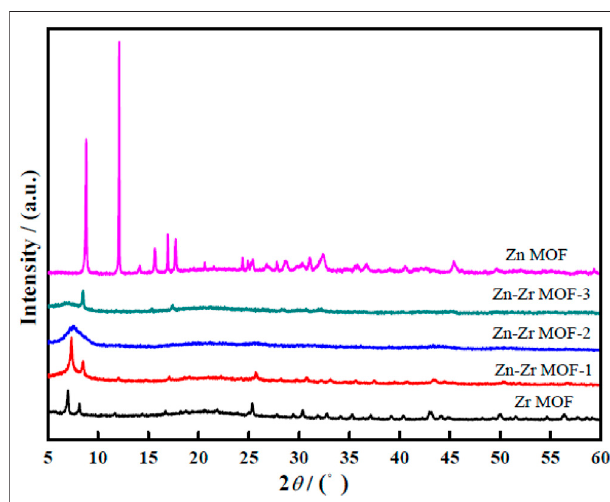
FIGURE 2 | XRD patterns of Zr MOF, Zn MOF, and Zn-Zr MOFs with different Zn:Zr molar ratios.